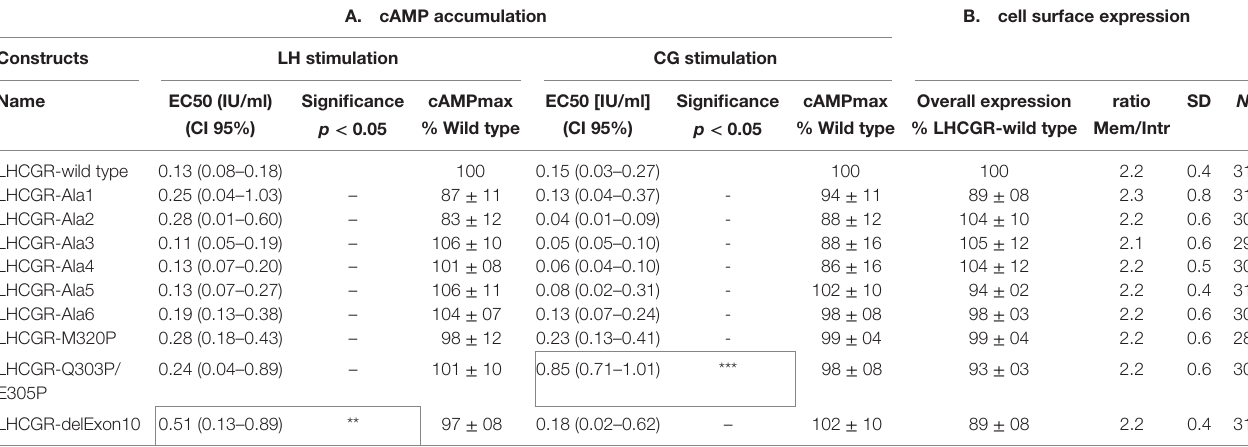
TaBle 1 | expression of ec 50 values and caMP-max values from caMP accumulation (a) and cell surface expression (B) of each lhcgr